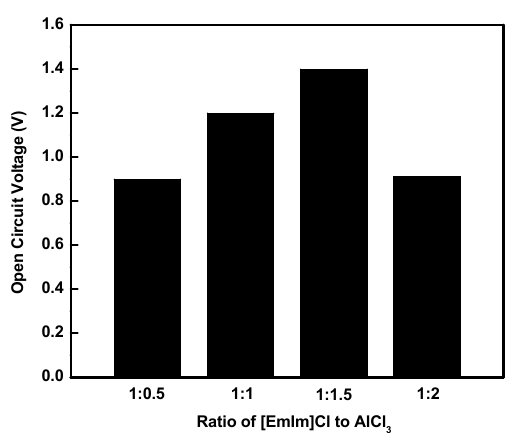
Figure 3. Effect of chloride ion concentration on open circuit voltage (OCV).